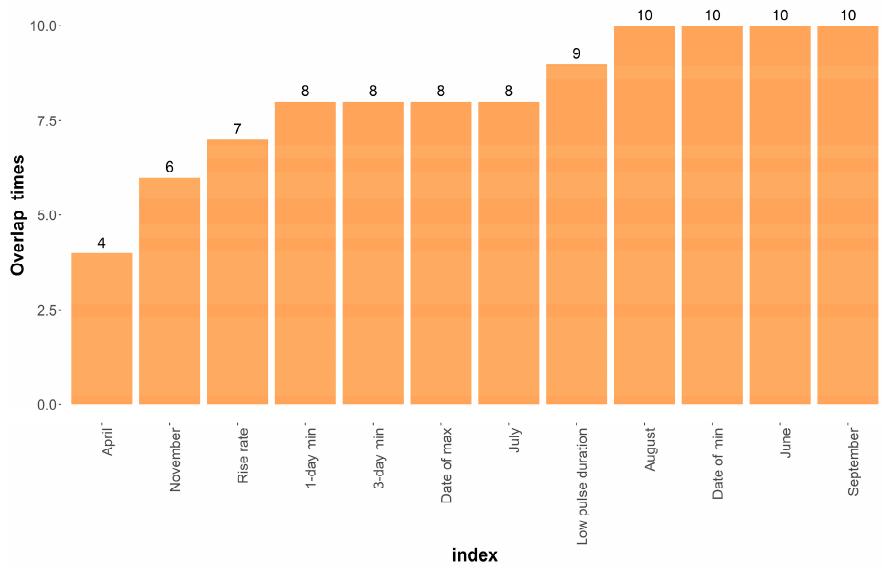
Figure 6. Overlap times of variation coefficient of ERHIs.